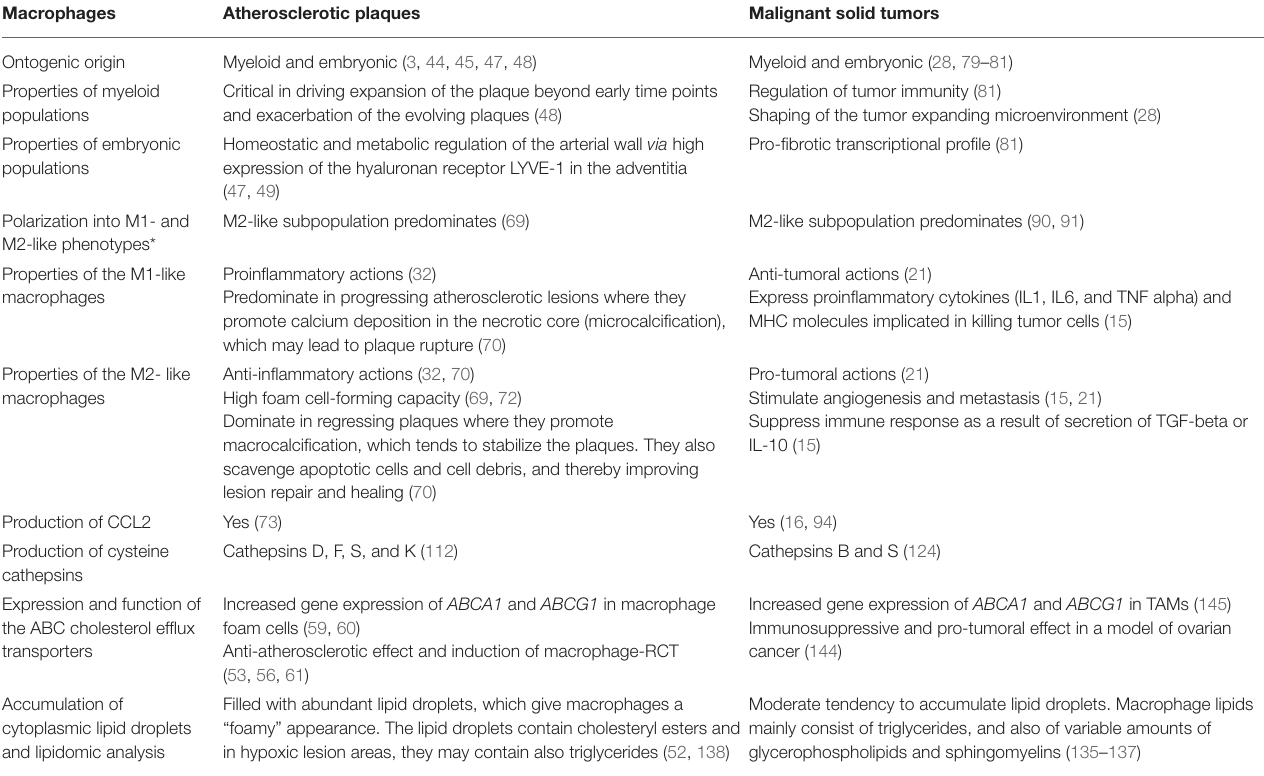
TABLE 2 | Ontogeny and phenotypic features of the macrophage populations in atherosclerotic plaques and malignant solid tumors.